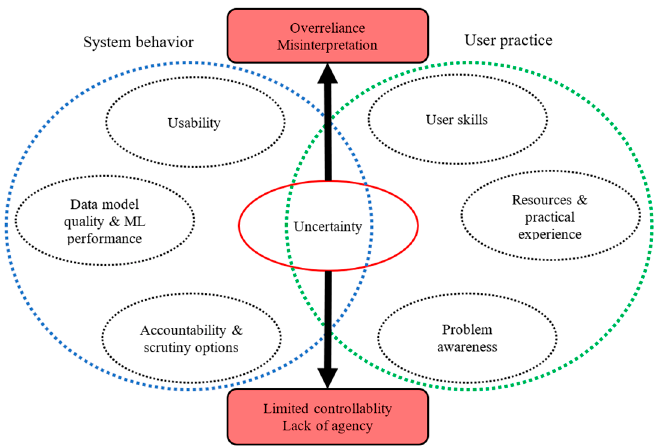
Figure 1. Main influencing factors of deep automation bias. The two circles represent the interplay between system behavior and user practice. Each circle contains different but interrelated factors that affect behavior and uncertainty on each side. Every factor also relates to its counterpart in the opposed circle on the same level (e.g., usability is linked to user skills, etc.).